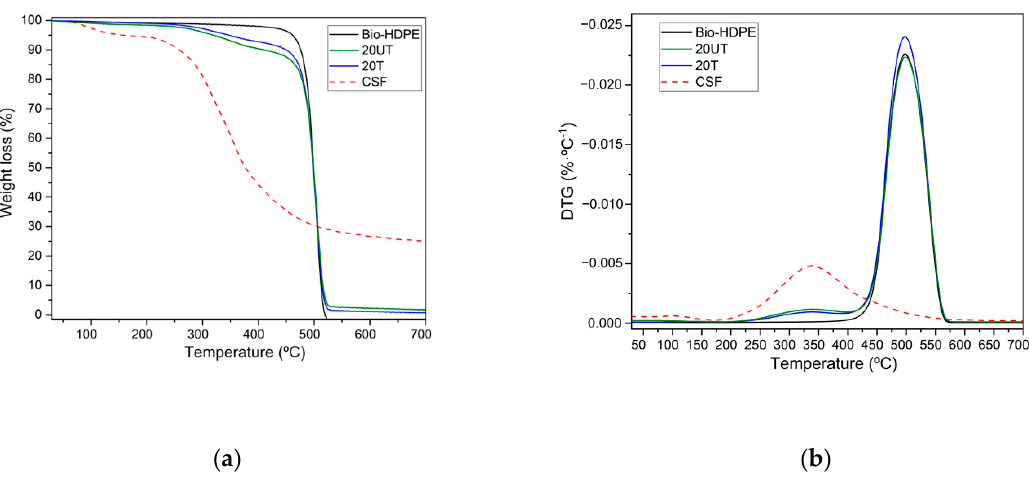
Figure 3. Thermal parameters of degradation of bio-based high-density polyethylene (Bio-HDPE) with 20 wt.% of untreated (20UT) and treated (20T) chia seed flour (CSF). ( a ) Weight loss; ( b ) Derivative thermogravimetry.